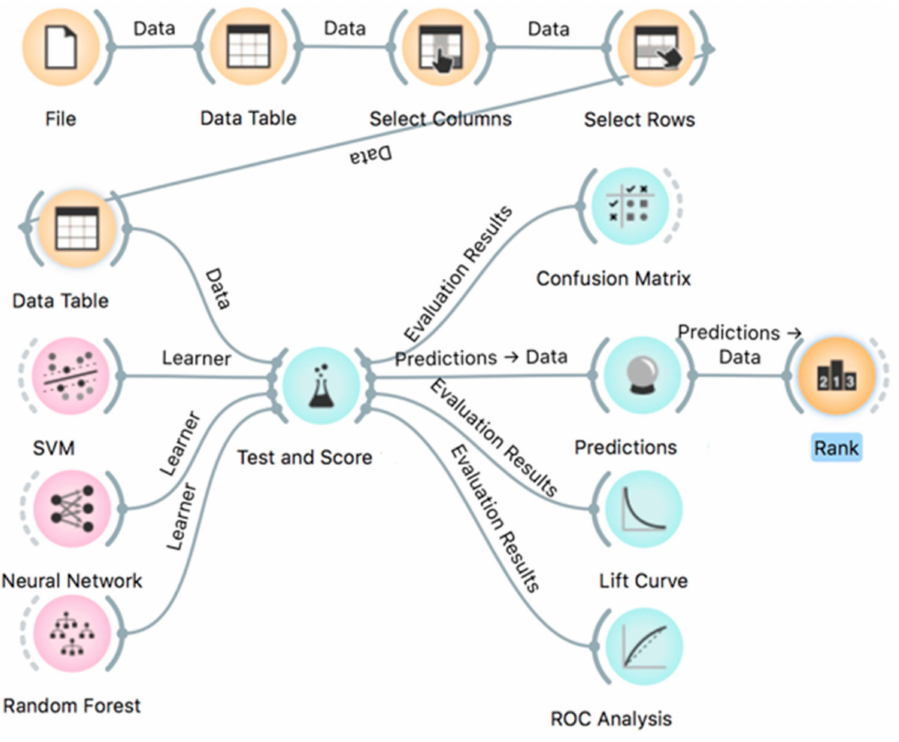
Figure 7. Orange workflow with selection of features and data mining tools. Supplementary Materials: The following are available online at https://www.mdpi.com/1422-006